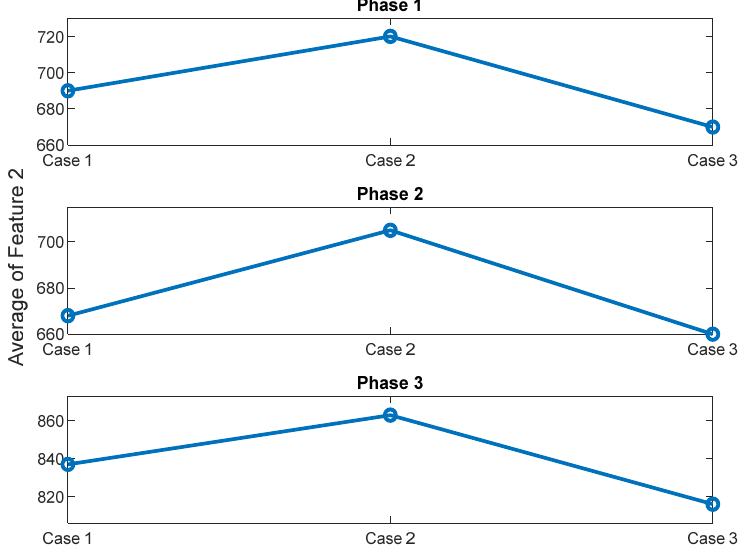
Figure 19. Average of Feature 2 for the three phases of the standard oil level for current signals, captured under different load conditions; Case1: no-load, Case2: 20 kg load (Day1) and Case 3: 20 kg load (Day2).